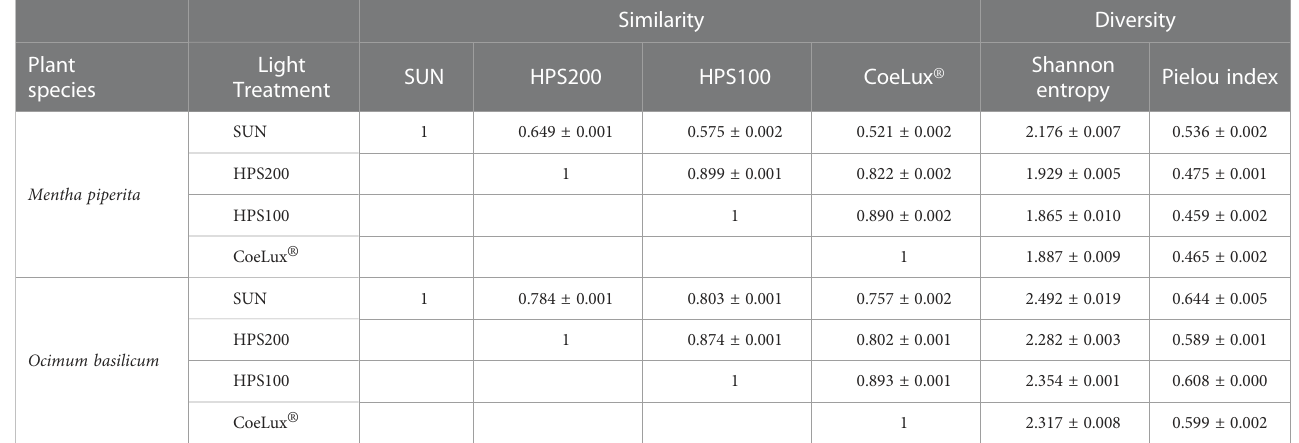
TABLE 2 Similarity and diversity in biochemical compounds composition of M. piperita and O. basilicum essential oils were assessed with the PMA similarity index (minimum similarity =0; max similarity =1) and whit Shannon entropy and Pielou index (minimum diversity =0; max diversity =1). The standard error of three technical replicates is reported.